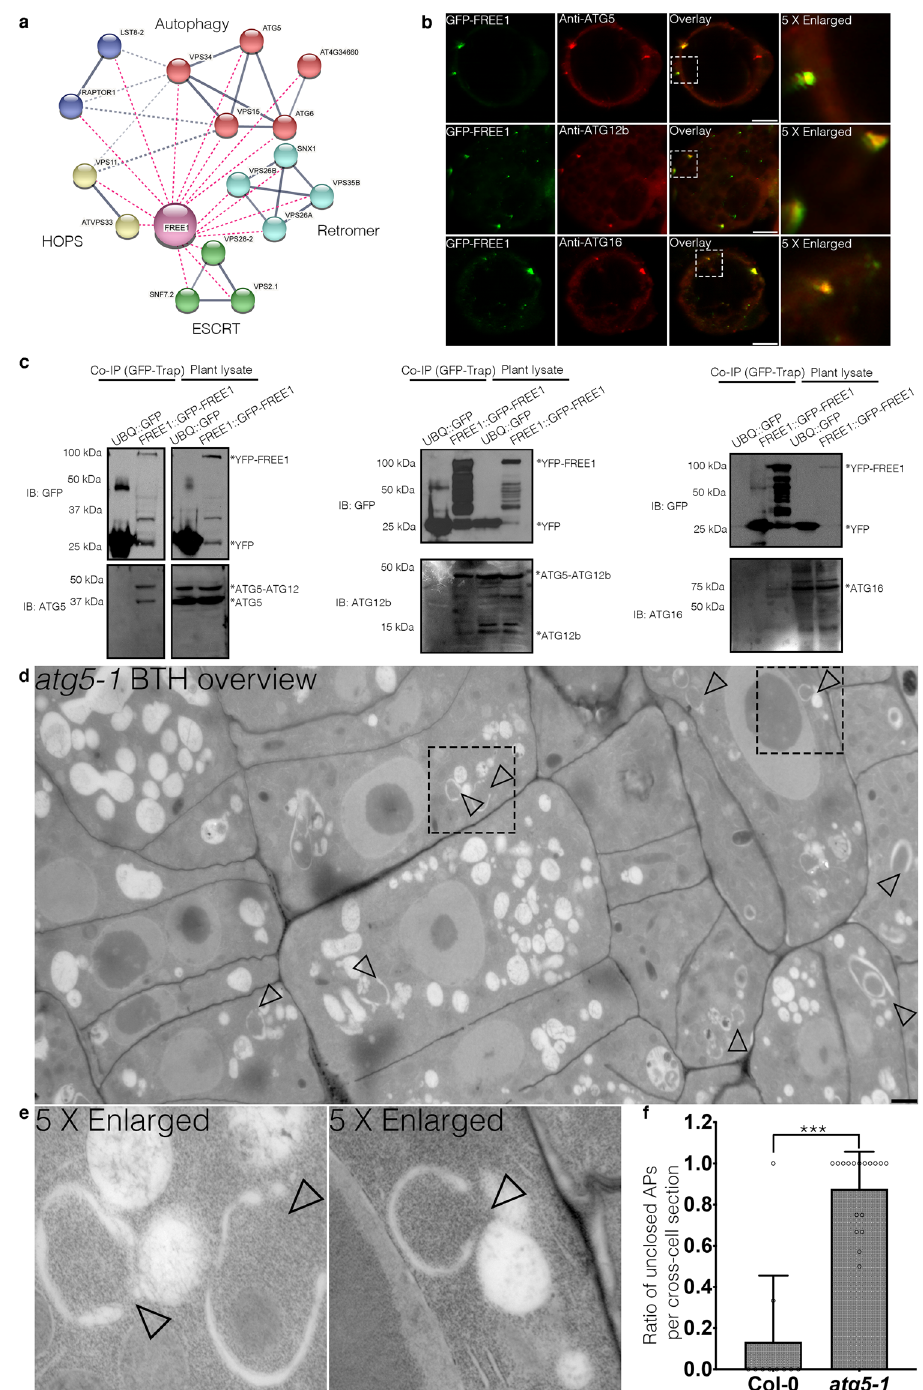
Fig. 2 | FREE1 interacts with ATG conjugation system and ESCRT-III under starvation conditions. a Transgenic Arabidopsis seedlings expressing YFP-FREE1 upon autophagy induction by carbon starvation for at least 18h were subjected to GFP-Trap assay for IP-MS analysis. Identi fi ed FREE1-interacting partners were ana- lyzed using STRING. b Immuno fl uorescence labeling of the endogenous ATG conjugation system proteins ATG5, ATG12b or ATG16 in Arabidopsis protoplasts transfected with GFP-FREE1 for 24h before confocal laser scanning microscopy (CLSM) observation. White dash boxes indicate the 5 X enlarged areas. Scale bars, 10 μ m. c GFP-Trapandco-IPanalysisofGFP-FREE1withendogenousATG5,ATG12b, or ATG16 using native promoter driven GFP-FREE1 transgenic plants. Arabidopsis transgenicplantsexpressingGFPorGFP-FREE1drivenbythenativepromoterwere